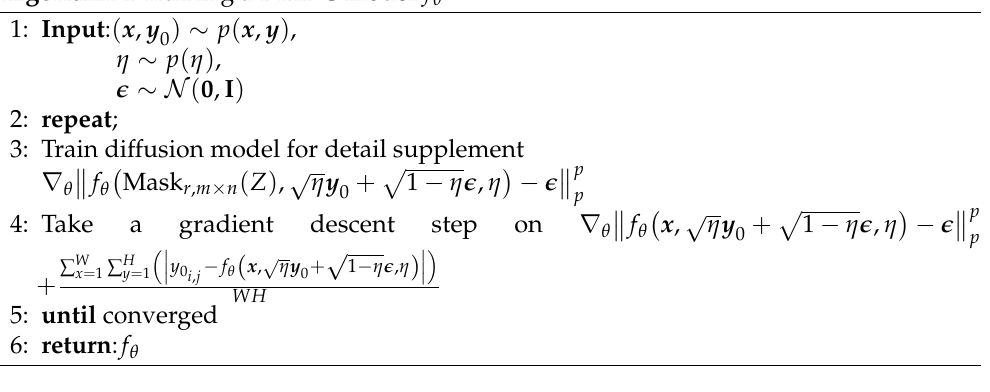
Algorithm 1 Training a DMDC model f θ